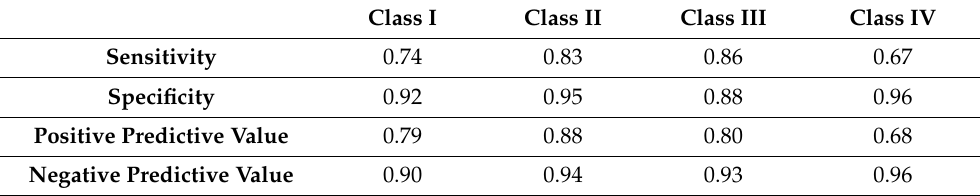
Table 2. Per class sensitivity, specificity, positive predictive value, and negative predictive value